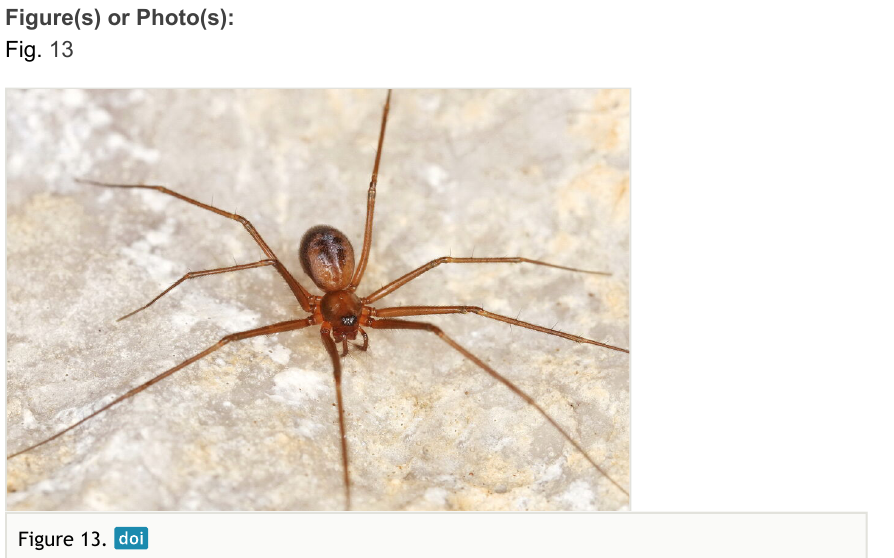
Figure(s) or Photo(s):